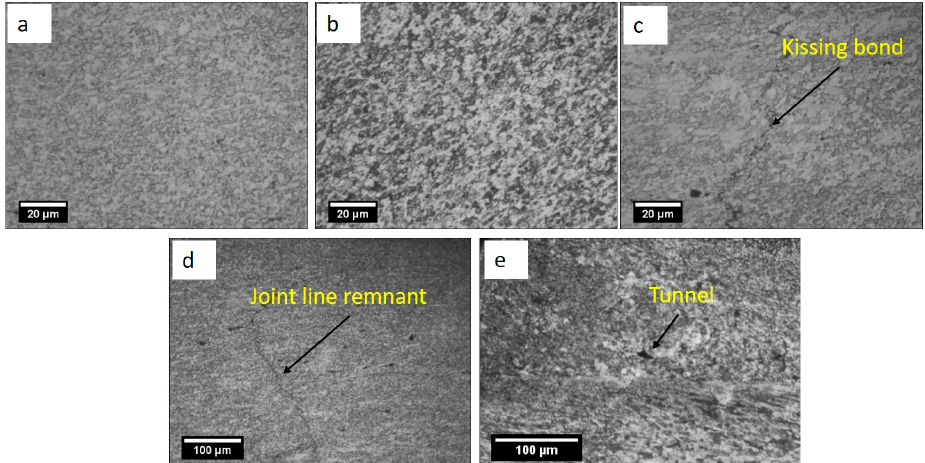
Figure 7. Butt joint micrographs obtained for specimen produced by using tools of ( a ) cylindrical pin; ( b ) tapered cylindrical pin; ( c ) square pin; ( d ) hexagonal pin; ( e ) triangular pin.